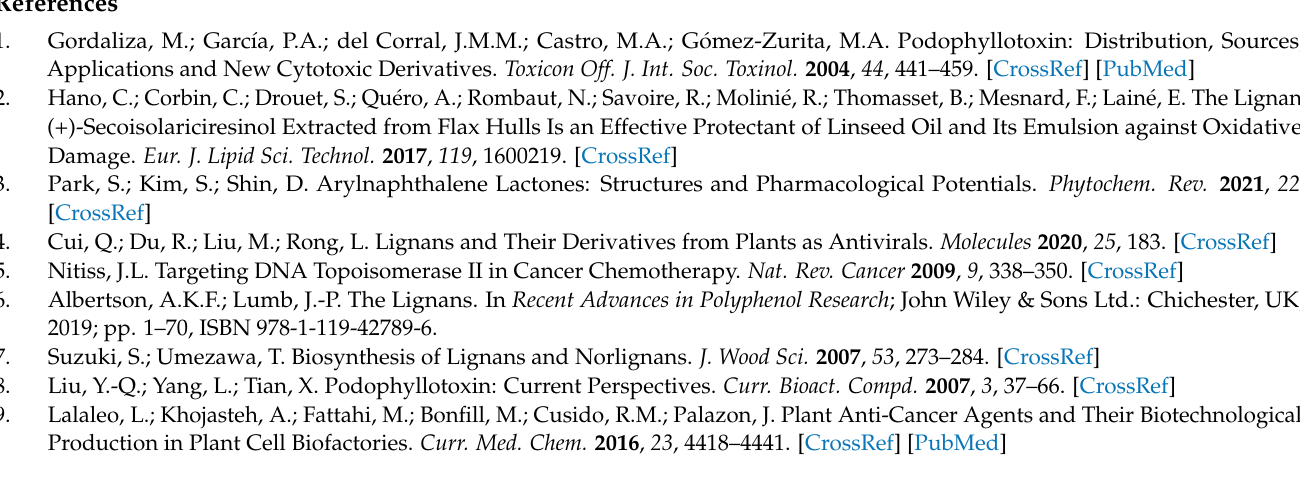
Figure S9: Tukey HSD post hoc test for PTOX, Figure S10: Tukey HSD post hoc test for MPTOX, Figure S11: Tukey HSD post hoc test for MPTOX—Glc, Figure S12: Correlation